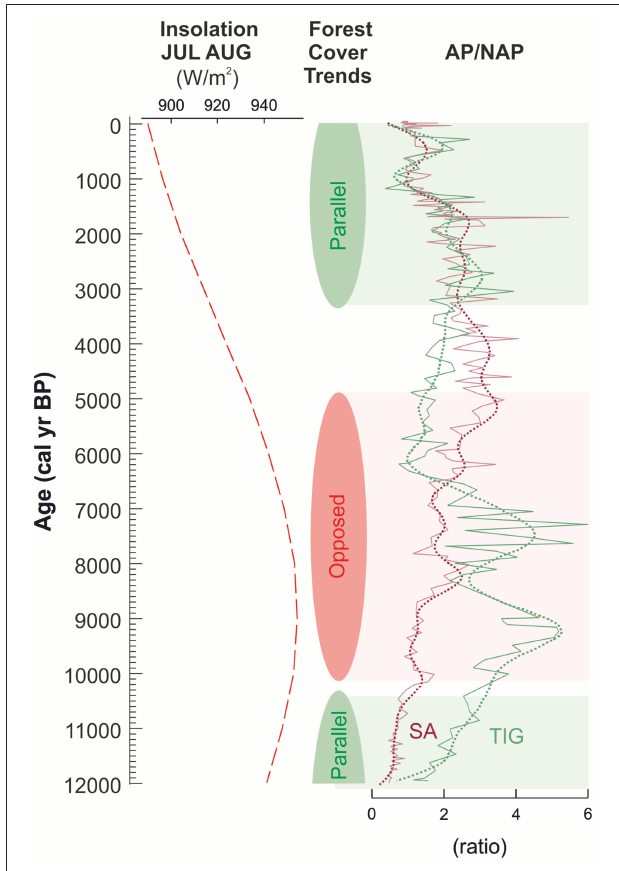
FIGURE 12 | Holocene millennial trends in forest cover at Lake Sidi Ali (SA) and Tigalmamine (TIG), highlighting intervals of parallel (green shading) and opposed (red shading) patterns of expansion and